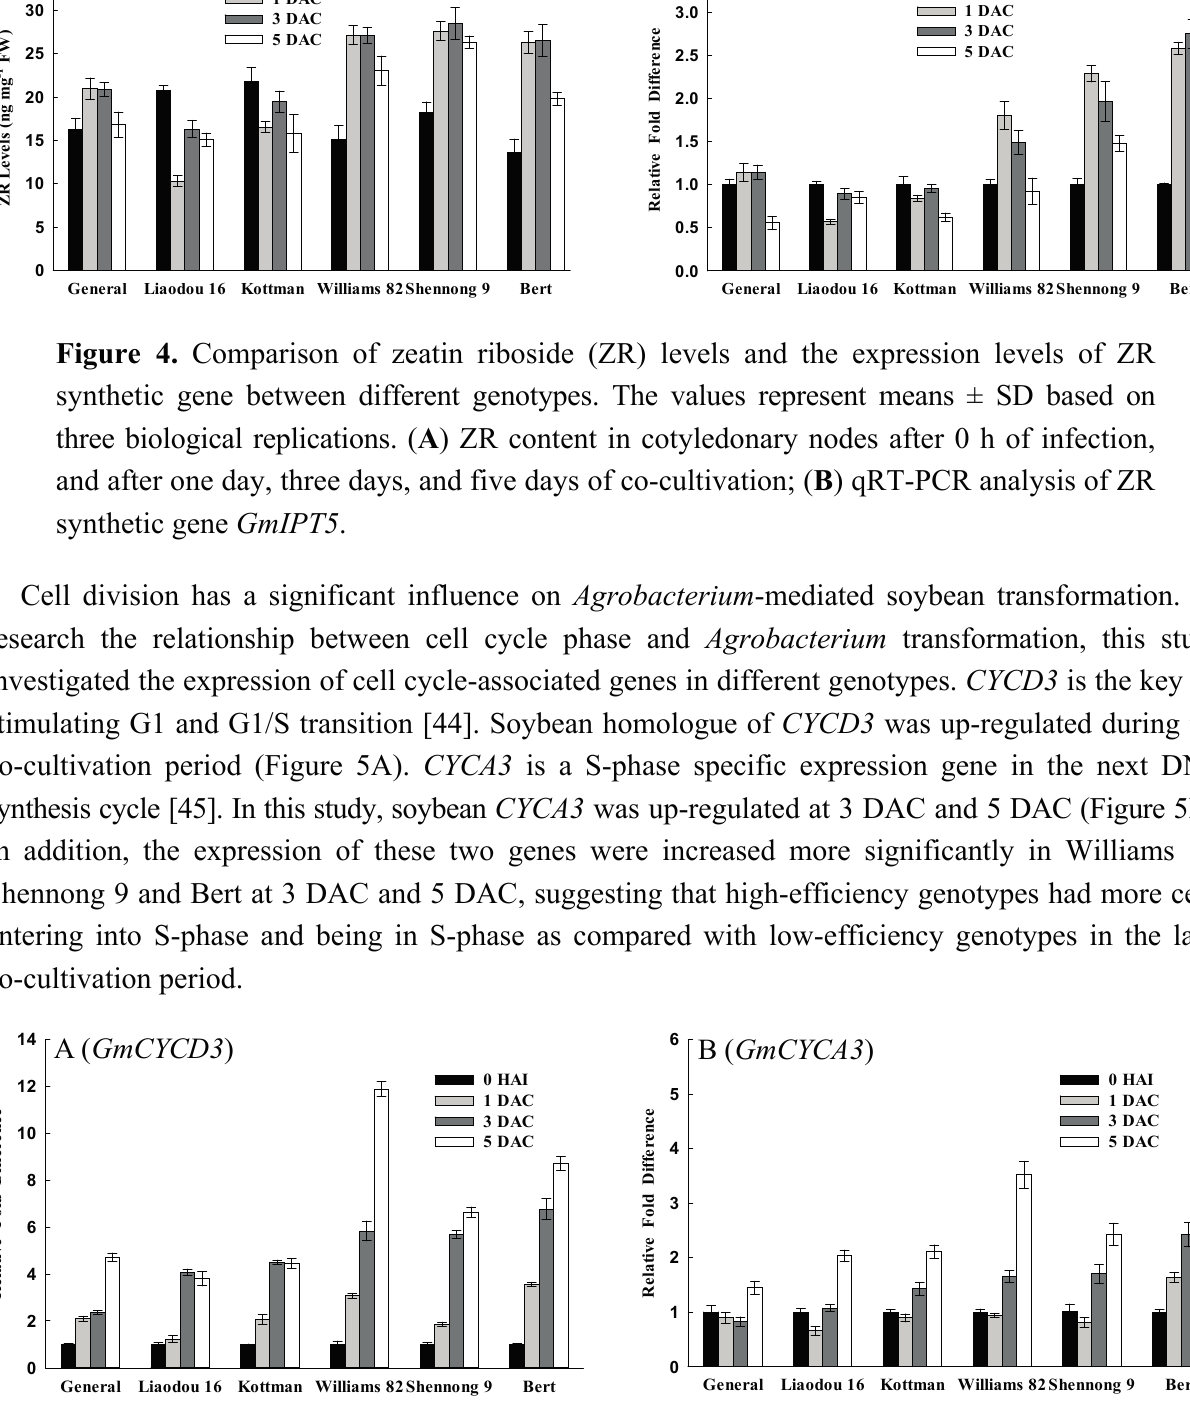
Figure 5. Comparison of the expression levels of cell cyclin-associated genes between different genotypes. The values represent means ± SD based on three biological replications. ( A ) qRT-PCR analysis of GmCYCD3 in cotyledonary nodes after 0 h of infection, and after one day, three days, and five days of co-cultivation; ( B ) qRT-PCR analysis of GmCYCA3